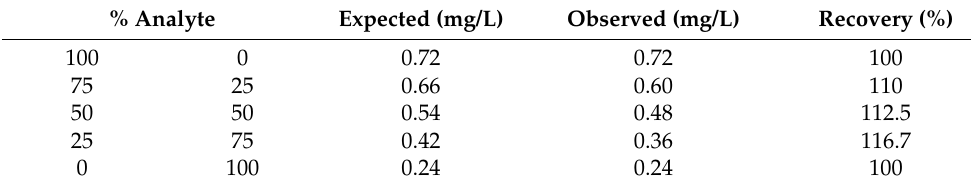
Table 2. Recovery study of the calprotectin assay in